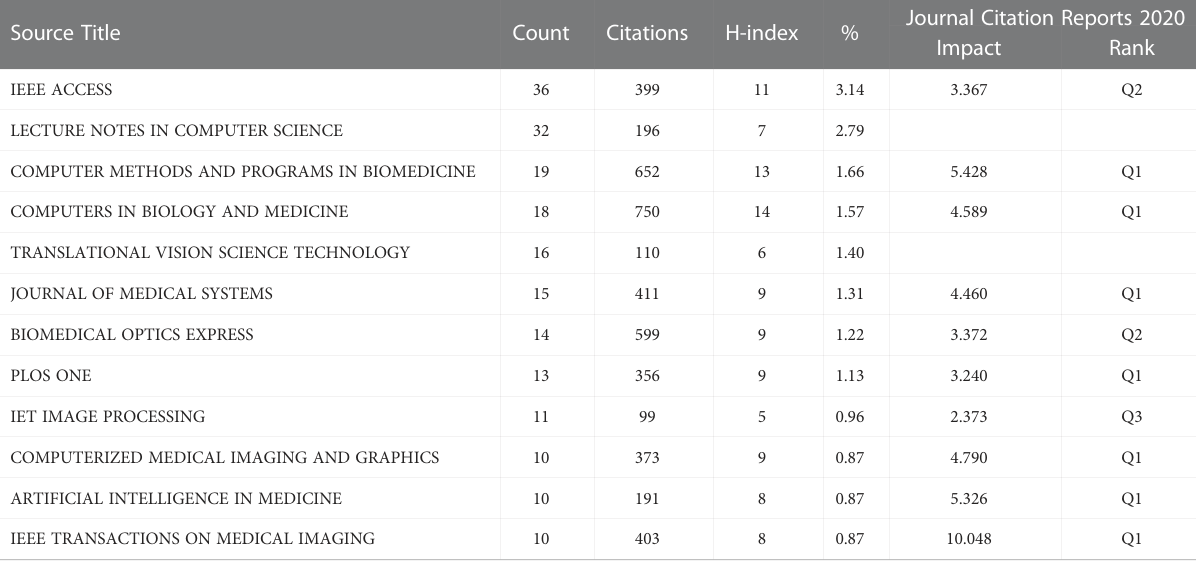
TABLE 6 Most productive journals ranked by publication